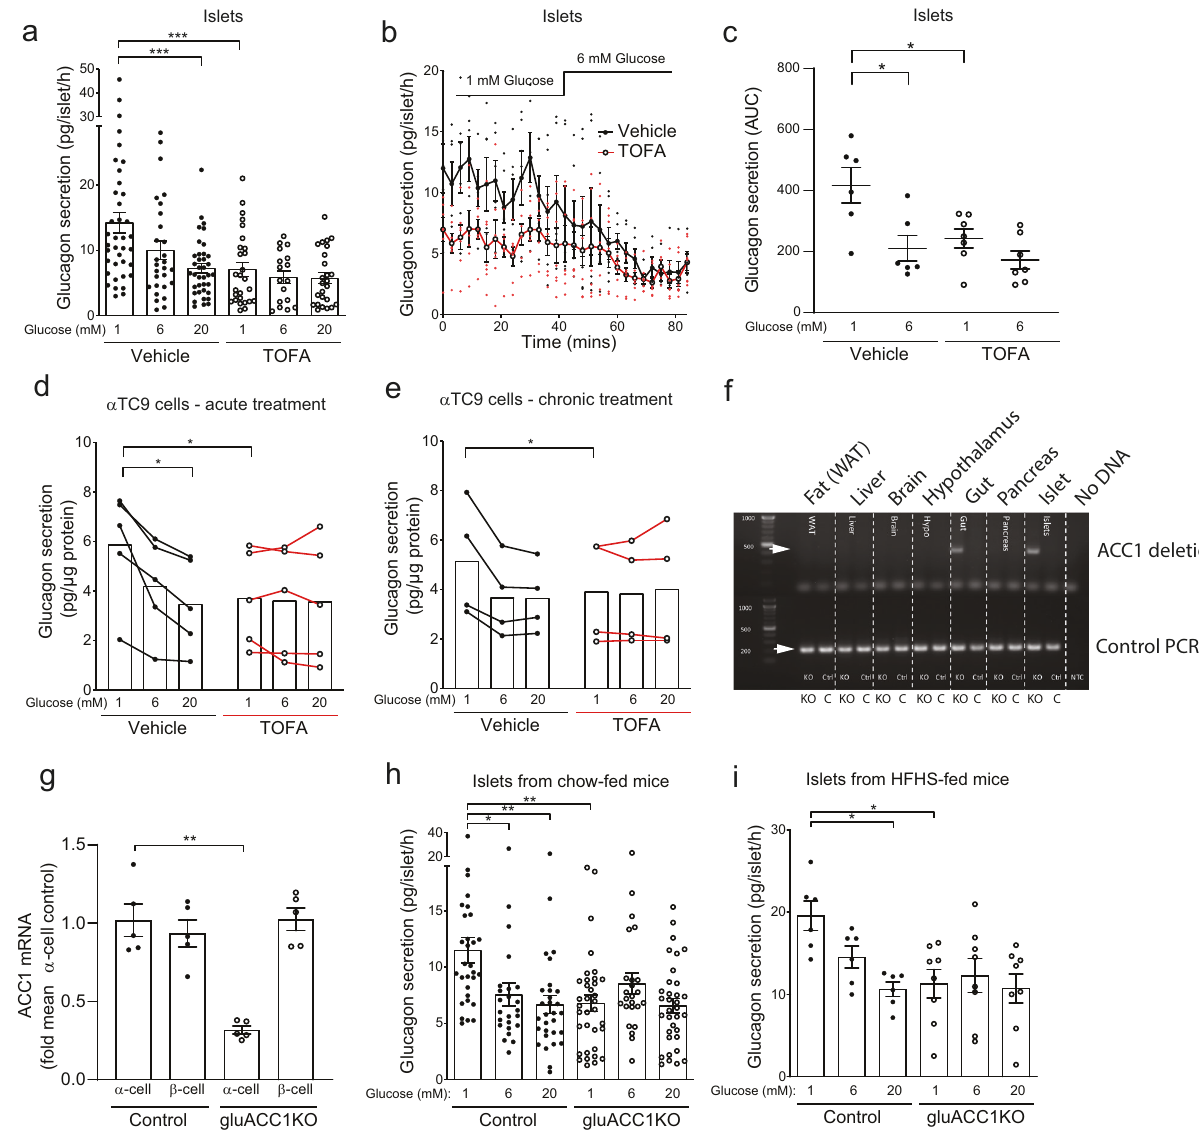
Fig. 1 Inhibition or genetic inactivation of ACC1 impairs glucagon secretion. a Pancreatic islets isolated from wild-type C57BL6/J mice (10 – 16 weeks of age) were treated with 25 µ M TOFA (ACC inhibitor; white circles) or vehicle (black circles) for 1h, prior to glucagon secretion assays. Data from n = 24 – 34 independent islet preparations were analysed by one-way ANOVA with Tukey multiple-comparisons test. b , c Wild-type islets treated with vehicle or TOFA for 1h prior to the assessment of time-resolved glucagon secretion by perifusion. Mean trace data ( b ) and area under the curve ( c ) are presented. Data from n = 6 – 7 independent islet preparations analysed by t -test. d , e α TC9 cells treated with TOFA for 1h ( d ) or 24h ( e ) prior to glucagon secretion experiments, with secretion data normalised to protein content per well. Data from n = 4 – 5 independent experiments analysed by paired t test. f Con fi rmation of ACC1 gene deletion in pancreatic alpha-cells. Genomic DNA was isolated from the indicated tissues and ampli fi ed using primers spanning the deleted region or a control region, to verify tissue speci fi city of ACC1 ( Acaca ) deletion. Gel represents three independent experiments analysing three independent mice. g ACC1 mRNA expression assessed by RT-PCR using cDNA from FACS-enriched alpha and beta cell populations, from n = 5 independent islet preparations analysed by Mann – Whitney test. h Pancreatic islets isolated from adult control (black circles) and gluACC1KO (white circles) mice, and glucagon secretion assessed. Data from n = 24 – 35 independent islet preparations were analysed by one-way ANOVA with Tukey ’ s multiple-comparisons test. i Glucagon secretion was assessed from islets isolated from mice following 12 weeks of exposure to a high-fat high-sucrose diet. Data from n = 6 – 8 independent islet preparations were analysed by one-way ANOVA with Tukey ’ s multiple-comparisons test. Data presented as mean±SEM. Signi fi cance thresholds: * P <0.05, ** P <0.01, *** P <0.001.